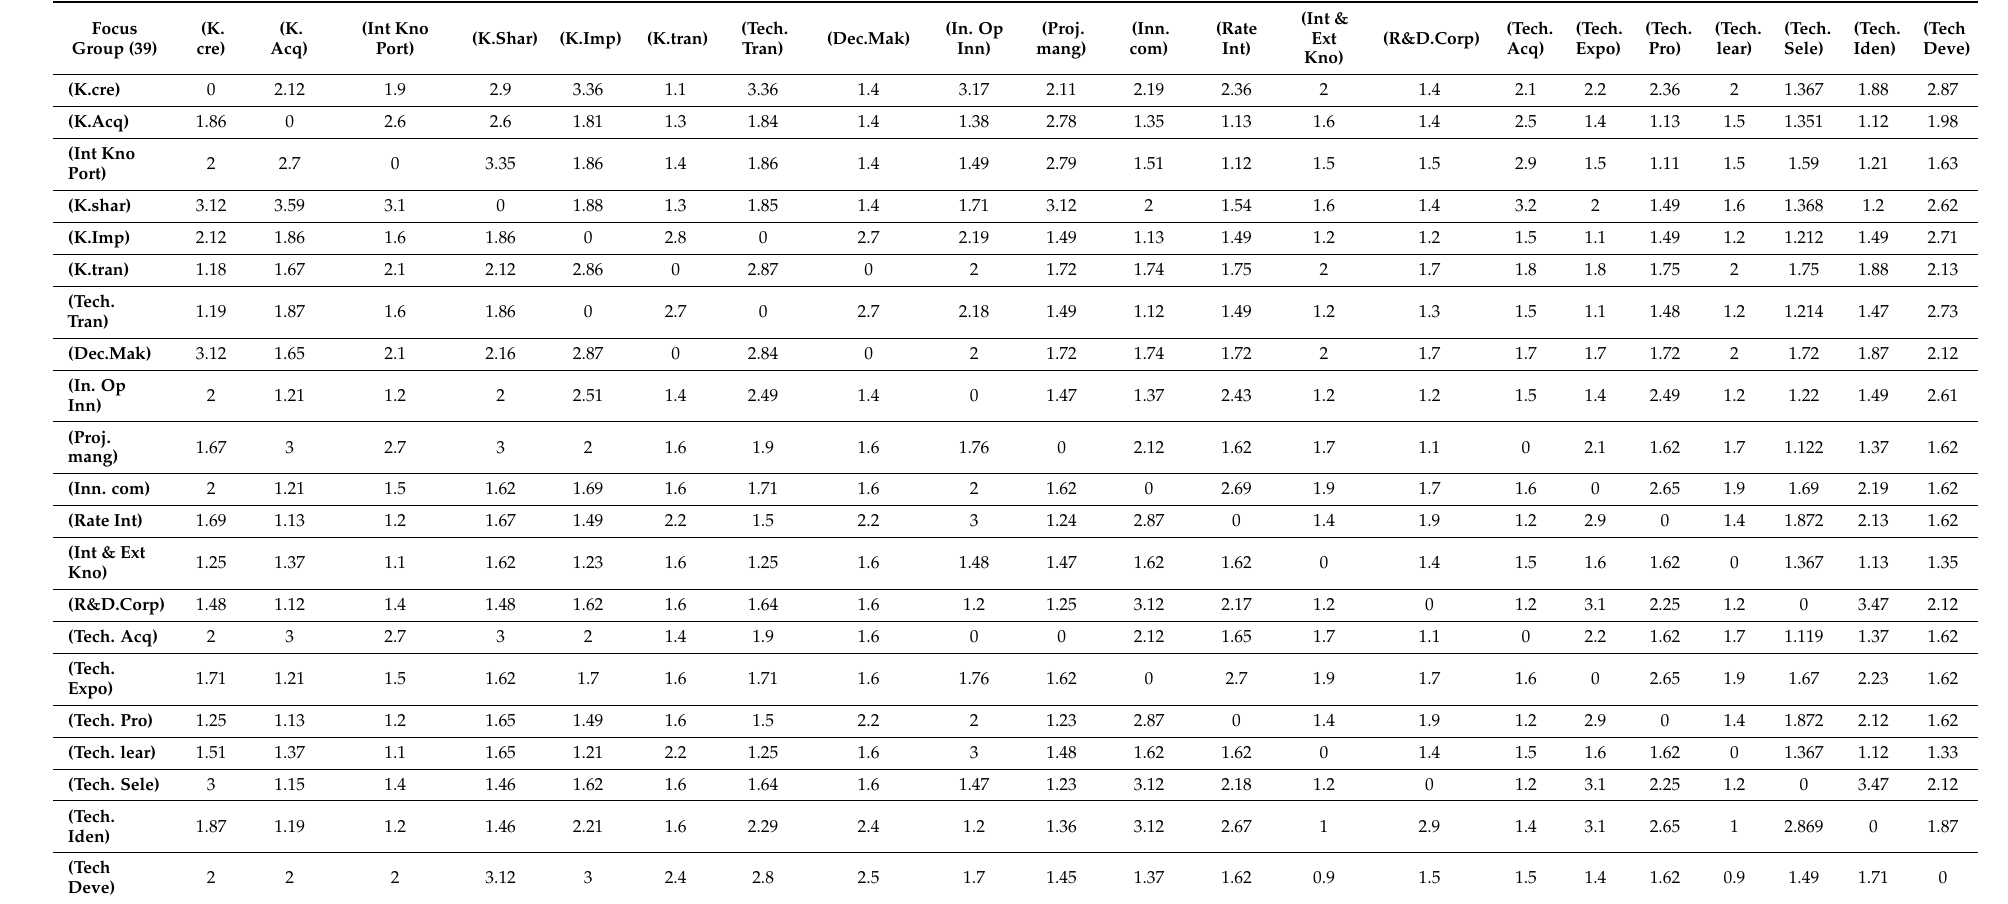
Table 3. The total average matrix T (Criteria) across 39